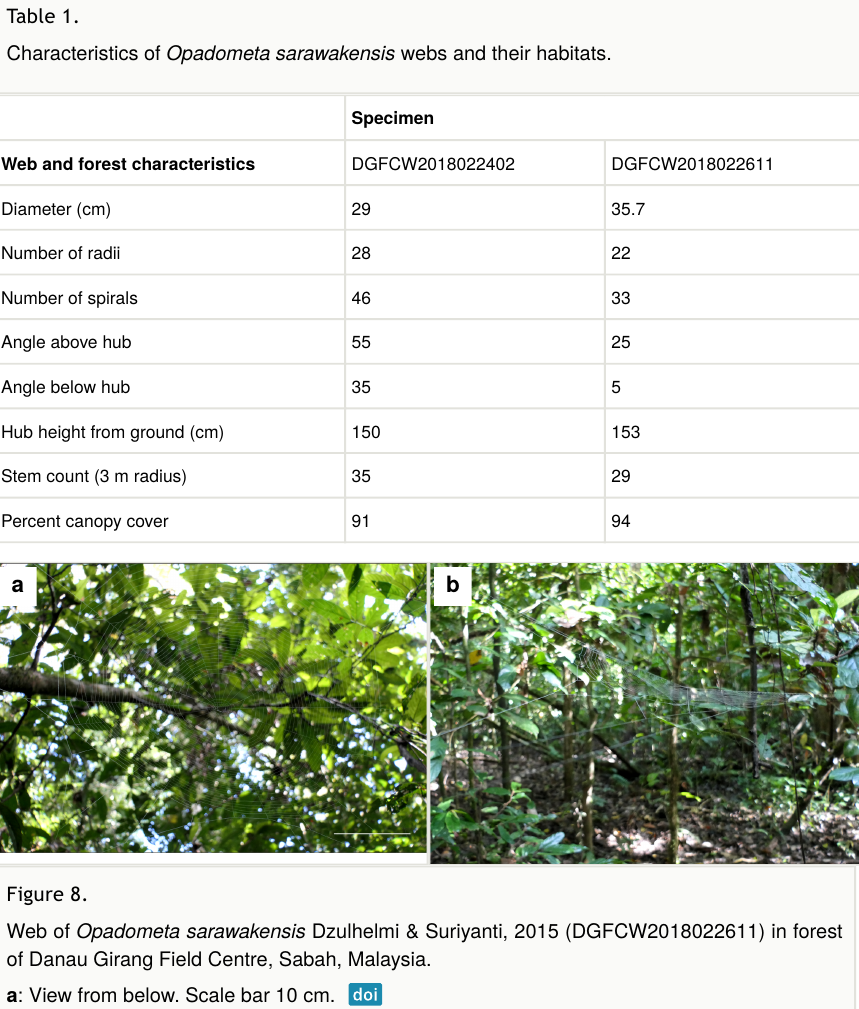
Field Center is located within the Lower Kinabatangan Wildlife Sanctuary, a narrow network of lowland riparian and riverine forest patches and corridors along the Kinabatangan River, surrounded by oil palm plantations.